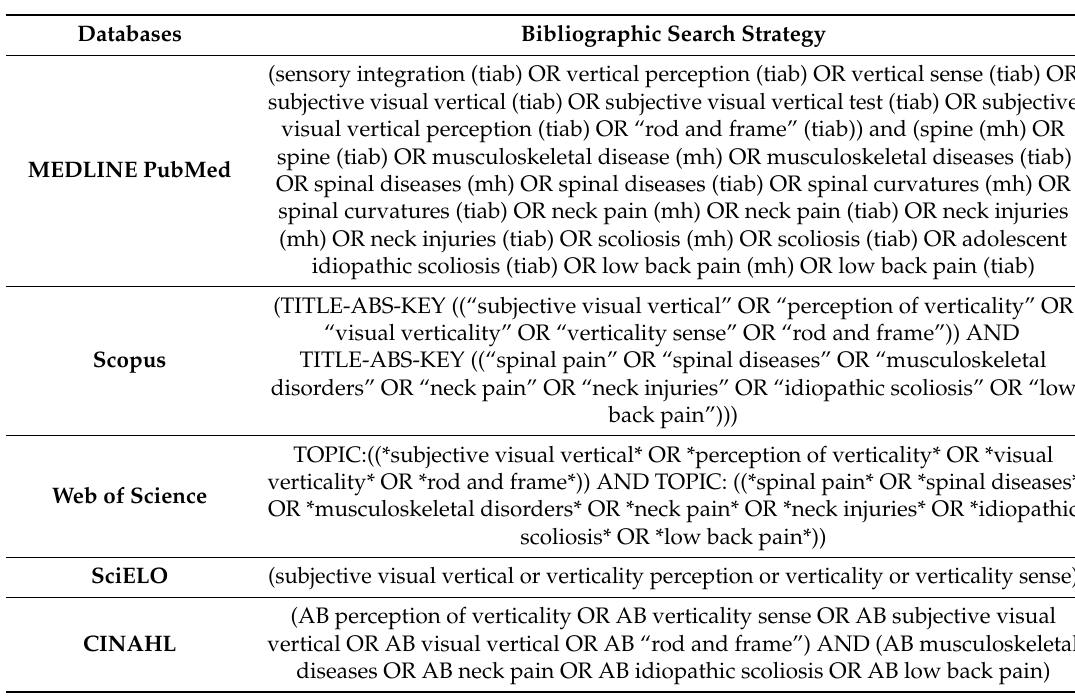
Table 1. Bibliographic search